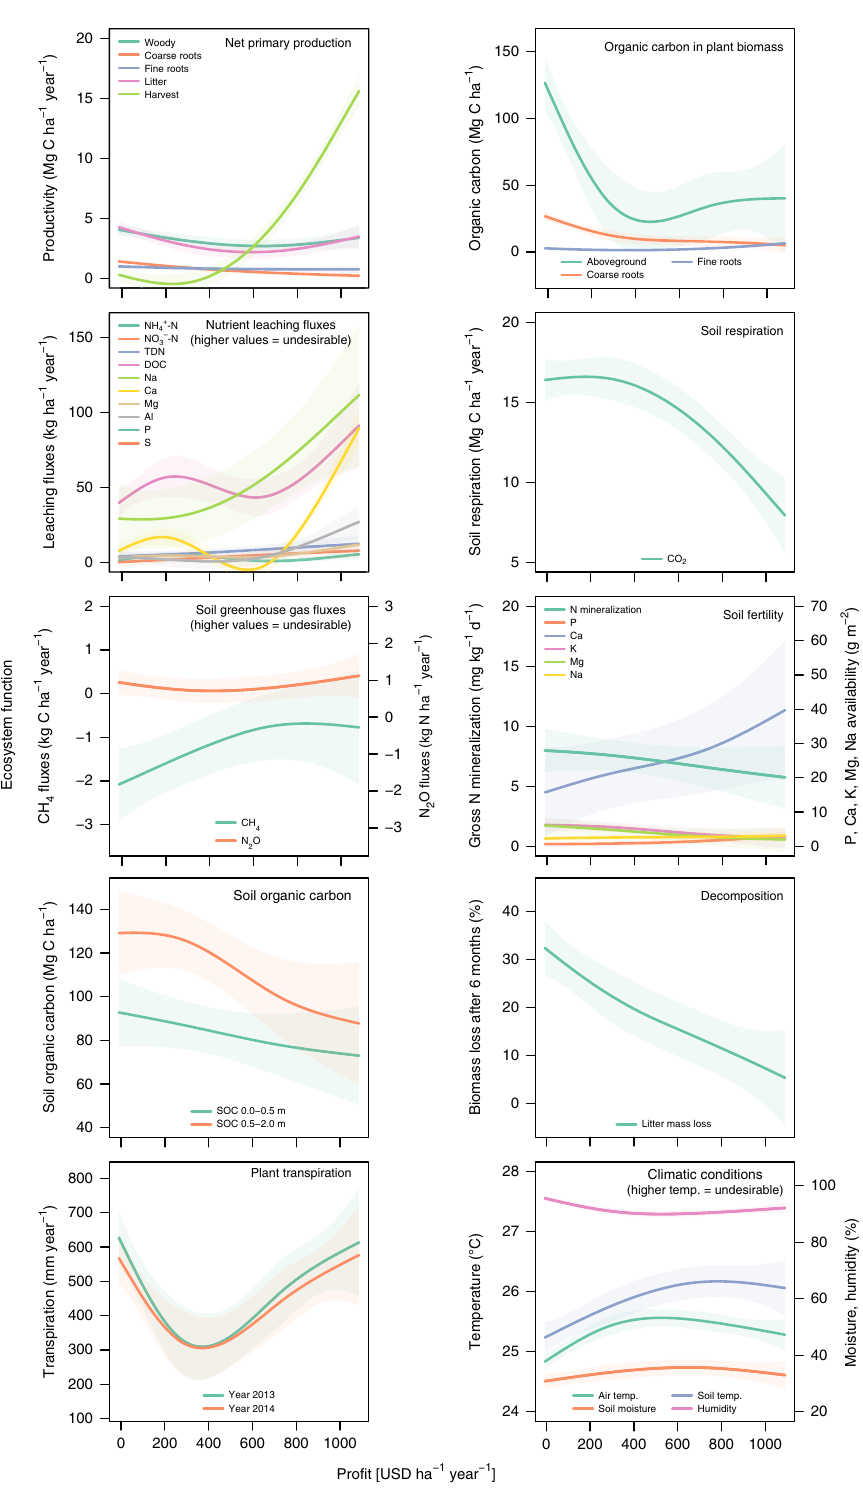
Fig. 3 Ecosystem functions and their indicators show diverging responses to increasing pro fi ts from land-use transitions by smallholders in an Indonesian landscape. Shown are responses of function indicators (thin lines: SIMEX predictions; shaded areas: 95% con fi dence bands). Source data are provided as a Source Data fi